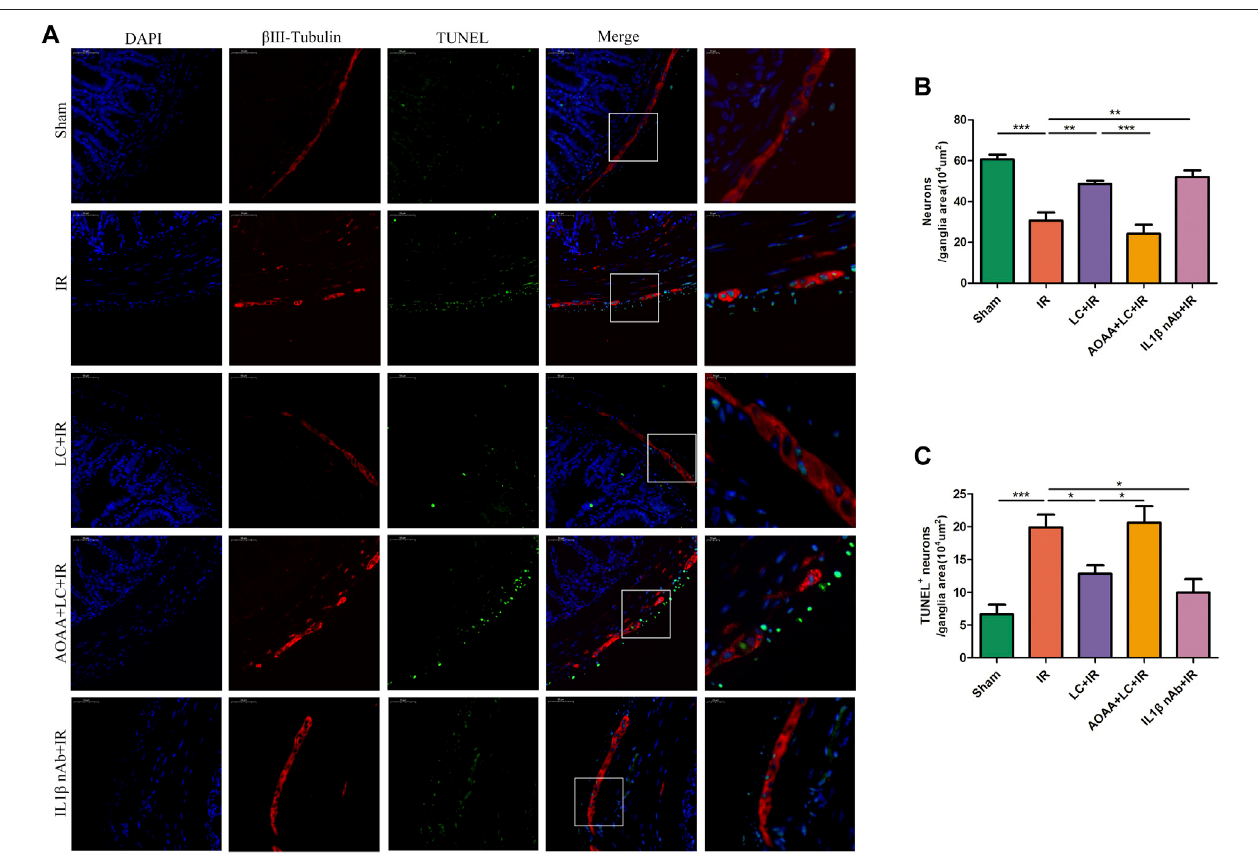
FIGURE7| L-CysdecreasedapoptosisofmyentericneuronscausedbyIR. (A) Representativephotographsofimmuno fl uorescentstainingofTUNEL(green), β Ⅲ - tubulin (red), and DAPI (blue). Scale bar = 50 μ m. N = 4 /group. (B,C) Quantitative analyses of the number of neurons and TUNEL + neurons in every 10 4 μ m 2 ganglion region.Sixrandomlycapturedimagesperanimalwereanalyzedforeachgroup. N=4 /group.Valuesare mean±SEM ,* p < 0.05,** p < 0.01,and*** p < 0.001according to ANOVA with the Newman – Keuls test.